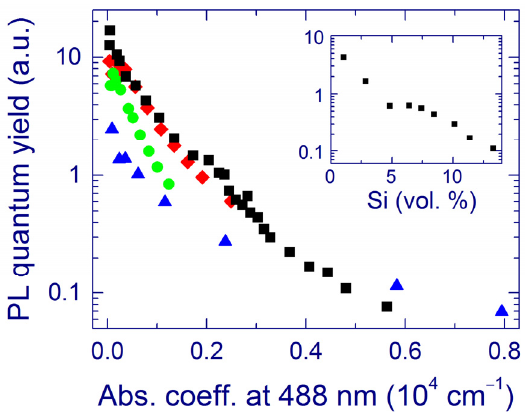
Figure 7. Relative PL quantum yield for SiO x films prepared by MBD for annealing at 1000 °C (triangles), 1100 °C (squares), 1150 °C (diamonds), and 1200 °C (circles) as a function of the absorption coefficient at 488 nm. The inset shows the relative PL quantum yield as a function of the amount of elemental Si for annealing at 1100 °C.